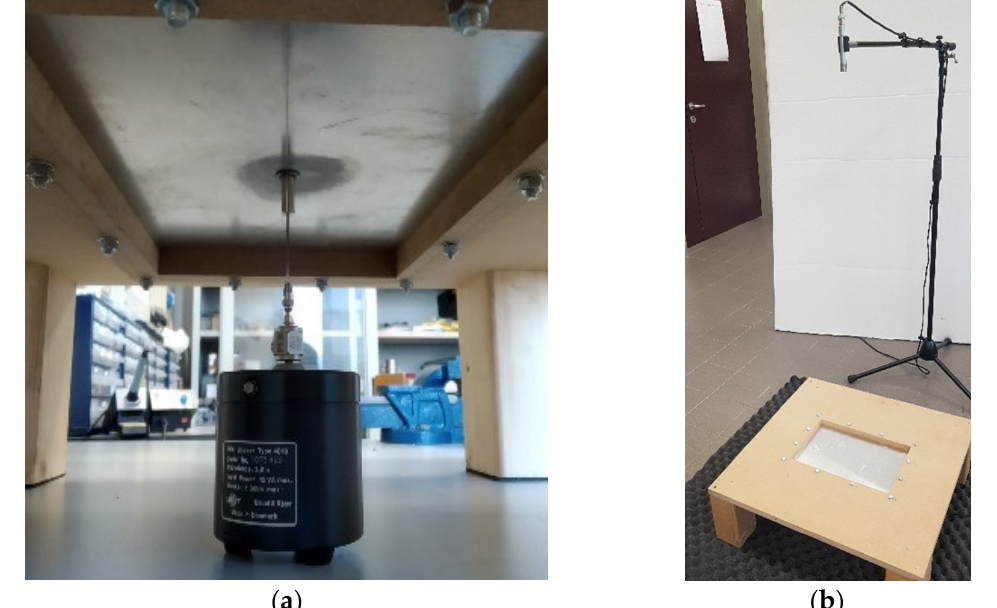
Figure 2. ( a ) B&K shaker type 4810 connected to the plate via a stinger. The PCB load cell is visible at the top of the shaker. ( b ) Acoustic measurement of the plate with a B&K microphone at 1 m on-